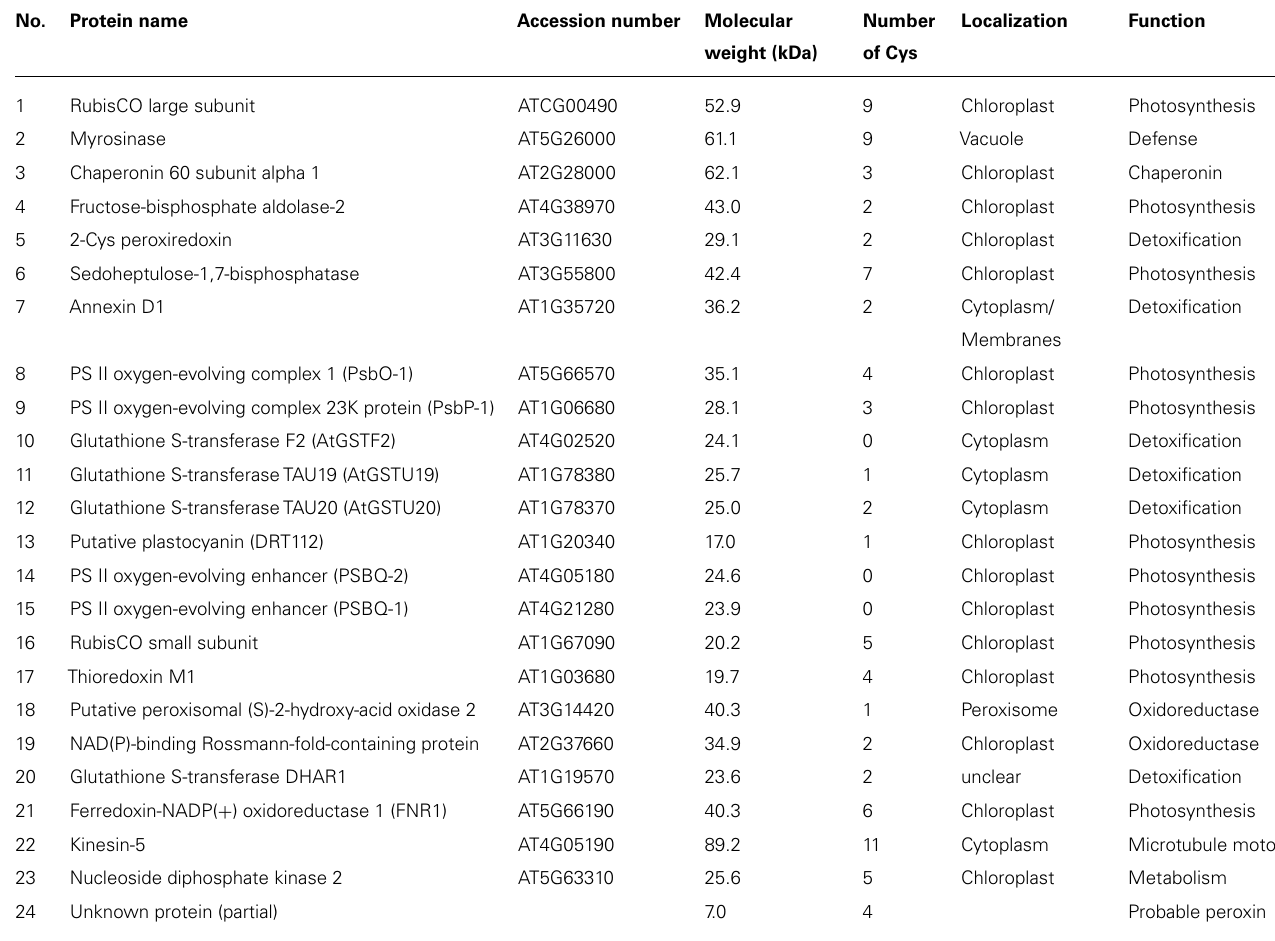
Table 3 | Oxidation-susceptible proteins in A. thaliana treated with methyl viologen, subjected to differential labeling and identified by